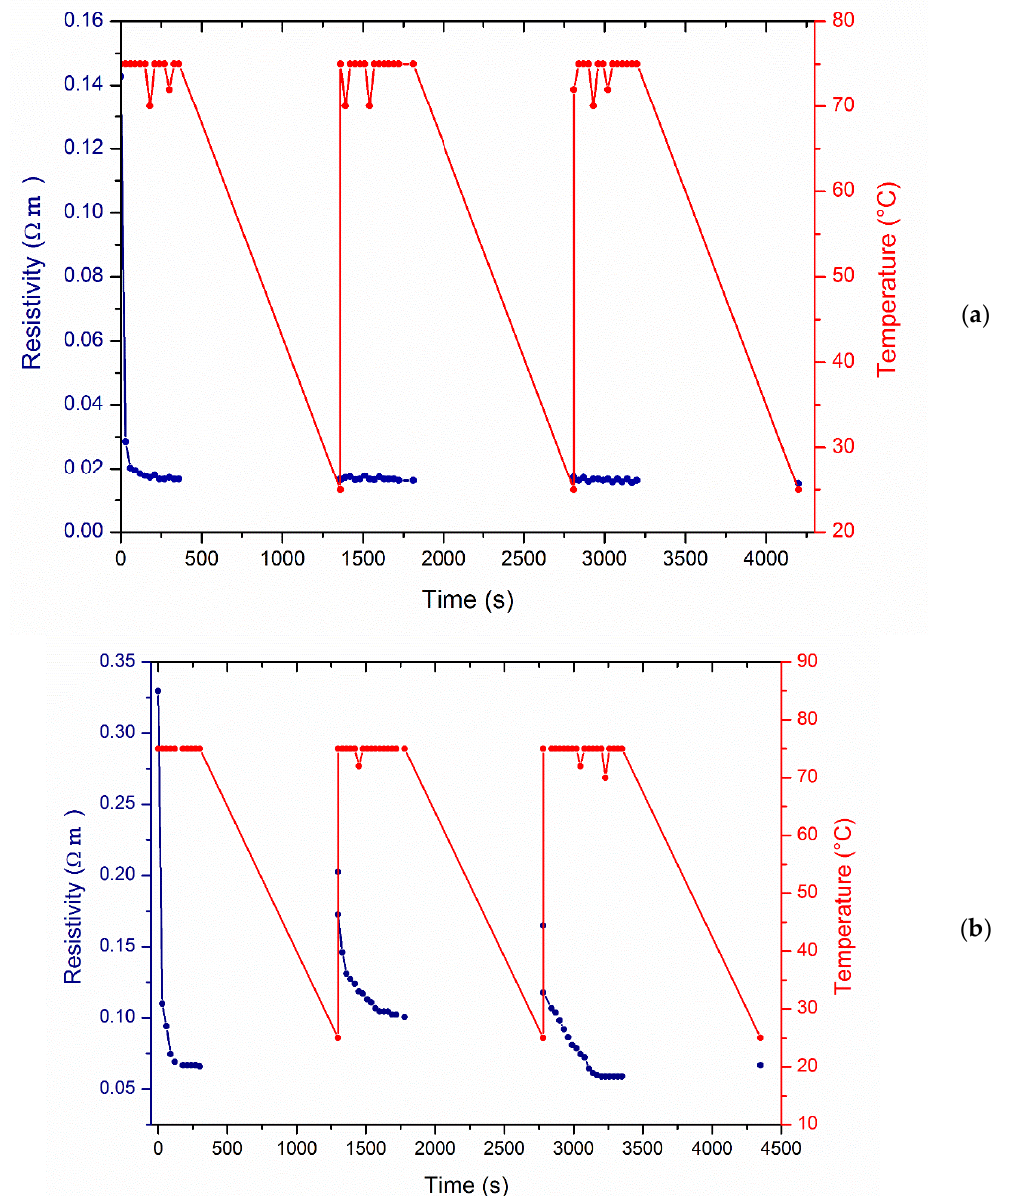
Figure 7. Resistivity changes of ( a ) PK30PMA and ( b ) PK30TMA nanocomposites containing the 8 wt % of MWCNTs as a function of heating–cooling cycles from 25 to 75 °C.